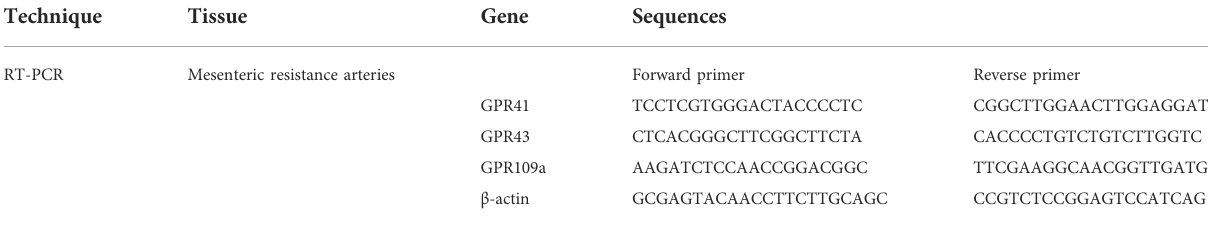
TABLE 2 Primer sequences used on RT-PCR for analysis of mesenteric arteries.